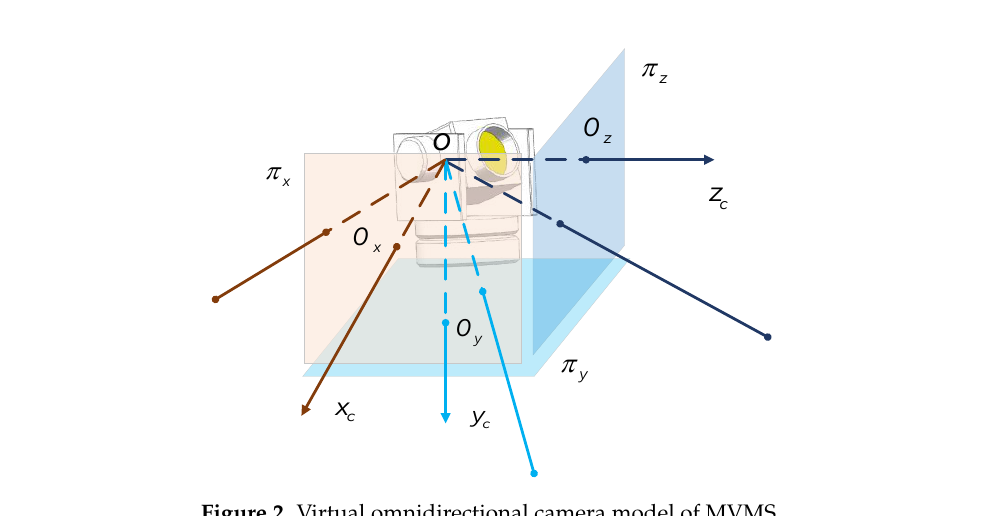
Figure 2. Virtual omnidirectional camera model of MVMS.